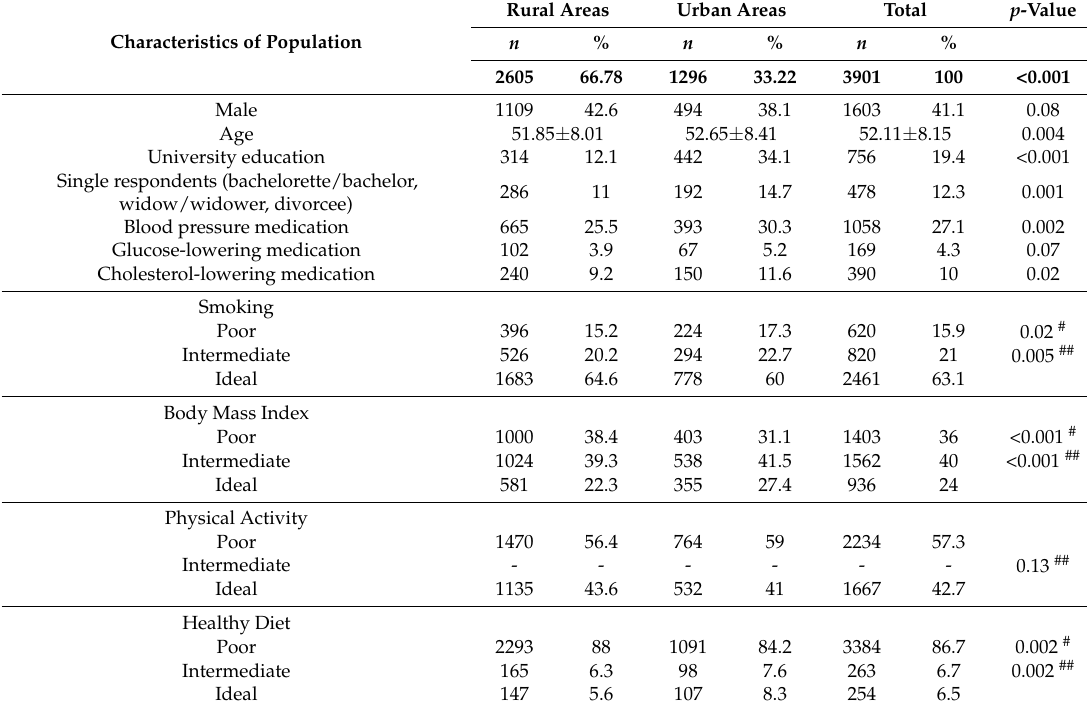
Table 1. Characteristics of the researched group according to their place of